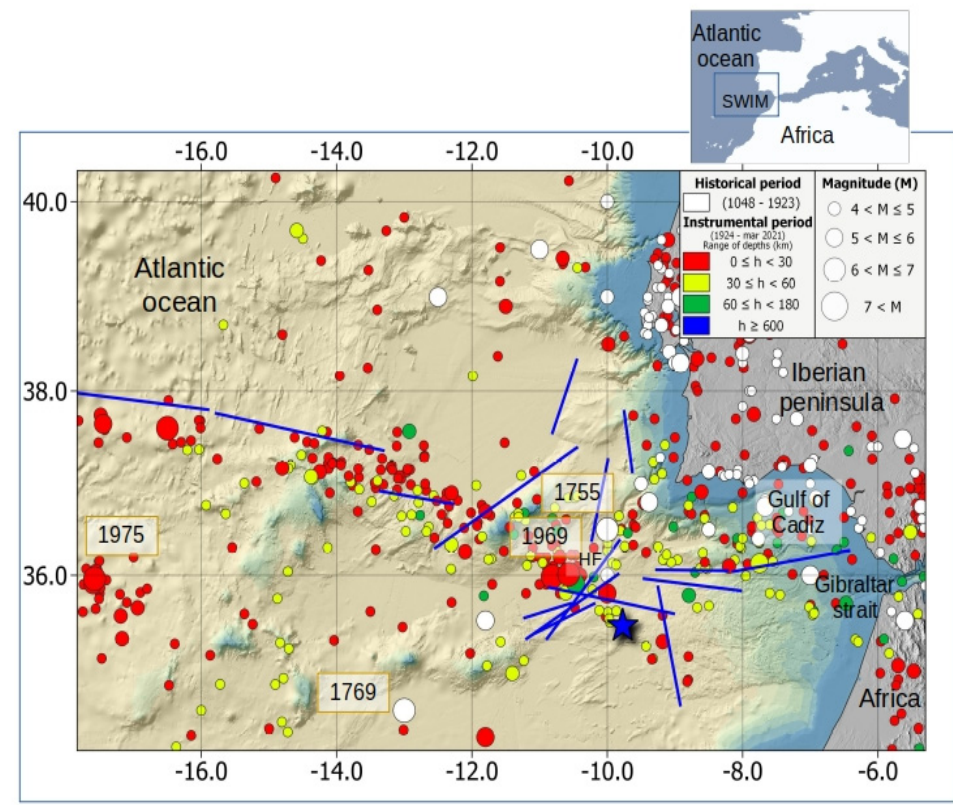
Figure 1. Seismicity of the Southwest Iberian Margin and the Gulf of Cadiz. Historical and instru- mental earthquakes (circles) [31]. Tsunami sources in the catalogue of the Spanish TWS [25] are labelled indicating their year of occurrence. Blue stars indicate the reference scenario locations of the synthetics computed in this study (Table A1). Faults used in the Spanish TWS database are denoted as blue lines [35]. HF indicates the Horseshoe trace fault location. Bathymetry comes from EMODNET and topography from the Digital Terrain Model 200 [36] and SRTM [37].